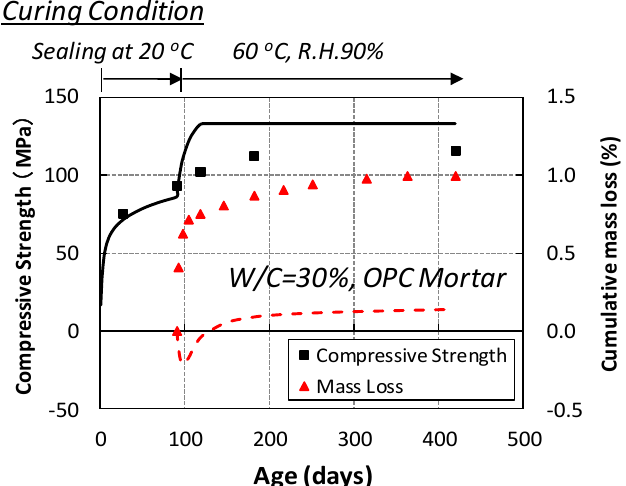
Figure 3. Comparison of compressive strength and weight loss. (Dot: experiment, Solid / chain line: analysis).